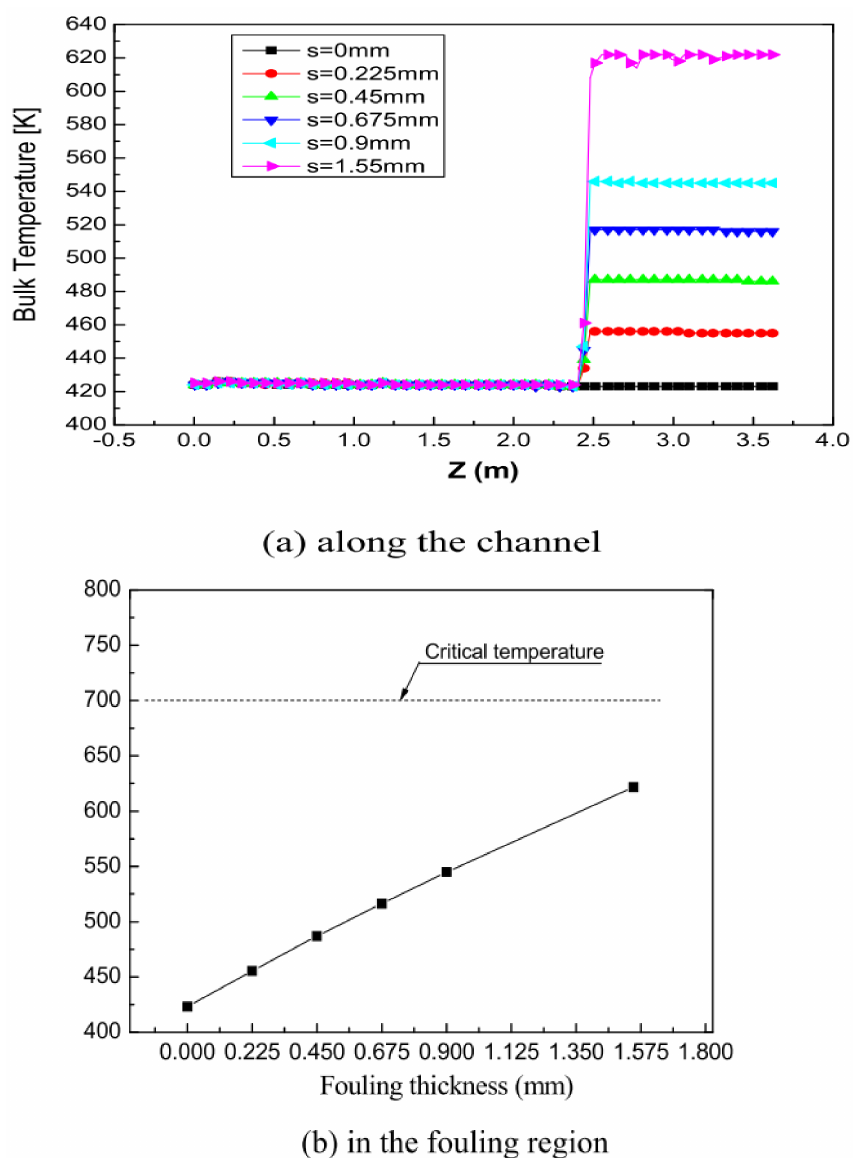
Figure 8. Bulk temperature along a tube for varying fouling layer thickness